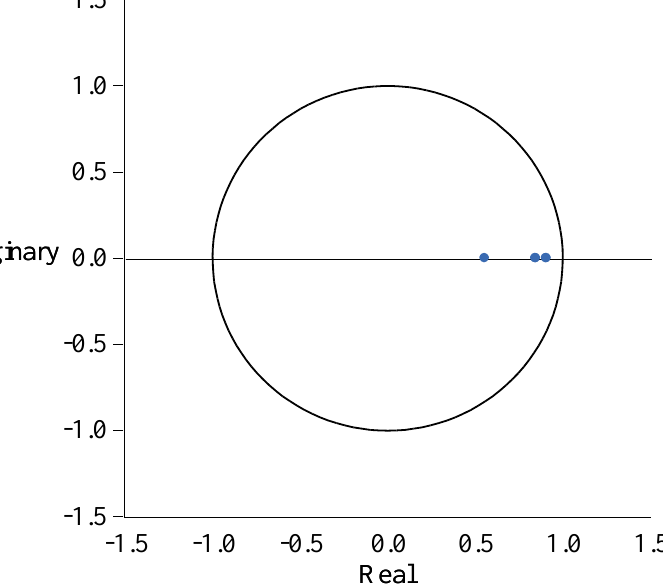
Figure 8. PVAR model robustness test